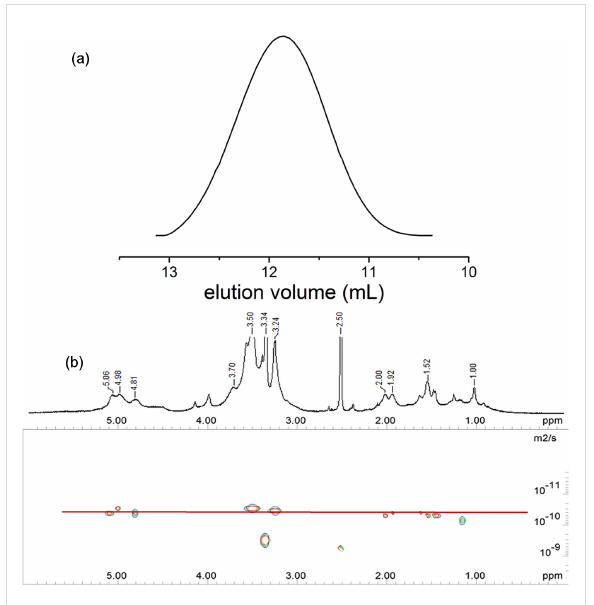
Figure 1: (a) GPC trace of the polyHEMA- co -polyisoprene poly- rotaxane 1 and (b) 500 MHz 1 H NMR and DOSY spectra of poly(TRIS- AAm)- co -polyisoprene polyrotaxane 2 in DMSO- d 6